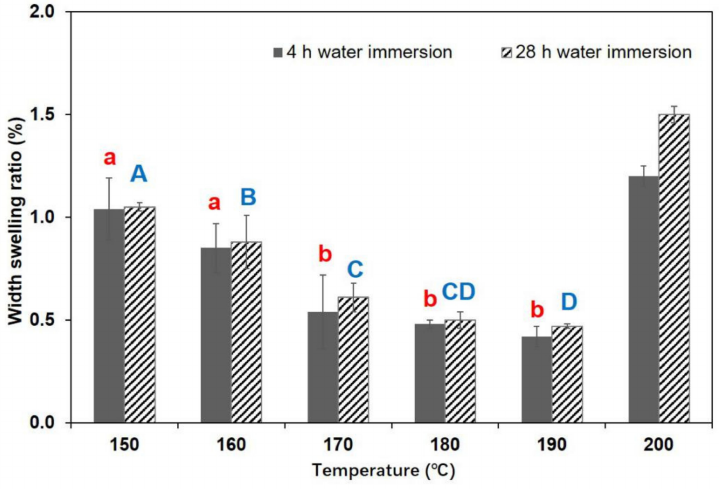
Figure 3. Width swelling results at different hot press temperatures (Notes: The same lowercase (4 h water immersion) and capital letter (28 h water immersion) are not significantly different at 5% significance level using Duncan’s post-hoc